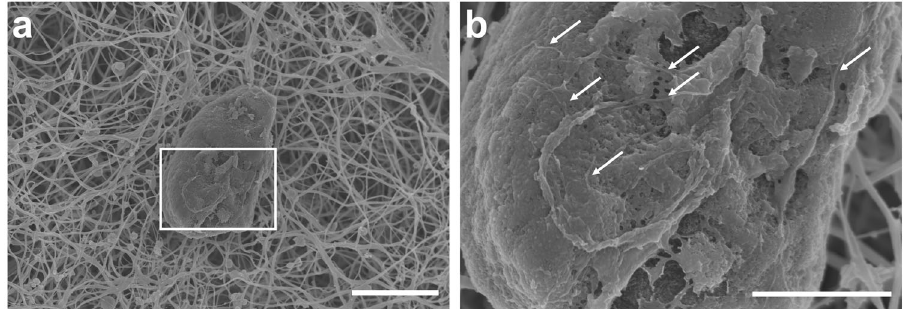
Fig. 2 High-resolution scanning electron micrographs of an aggregate in a PE patient plasma clot. The presence of aggregates was observed in clots using SEM ( a ). Small fi bres can be seen within the aggregate (white arrows; b ). Scale bars are 5 µ m ( a ) and 2 µ m ( b )